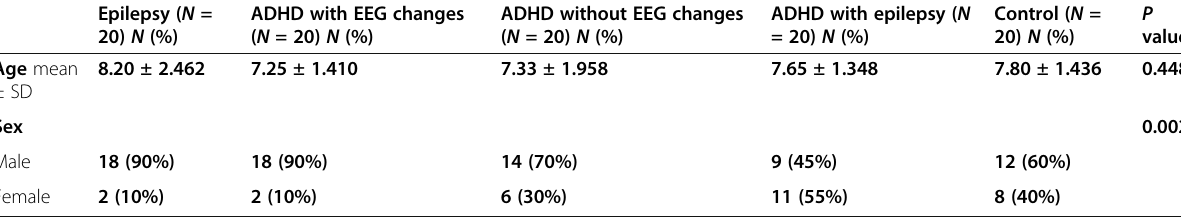
Table 1 Demographic features of studied group